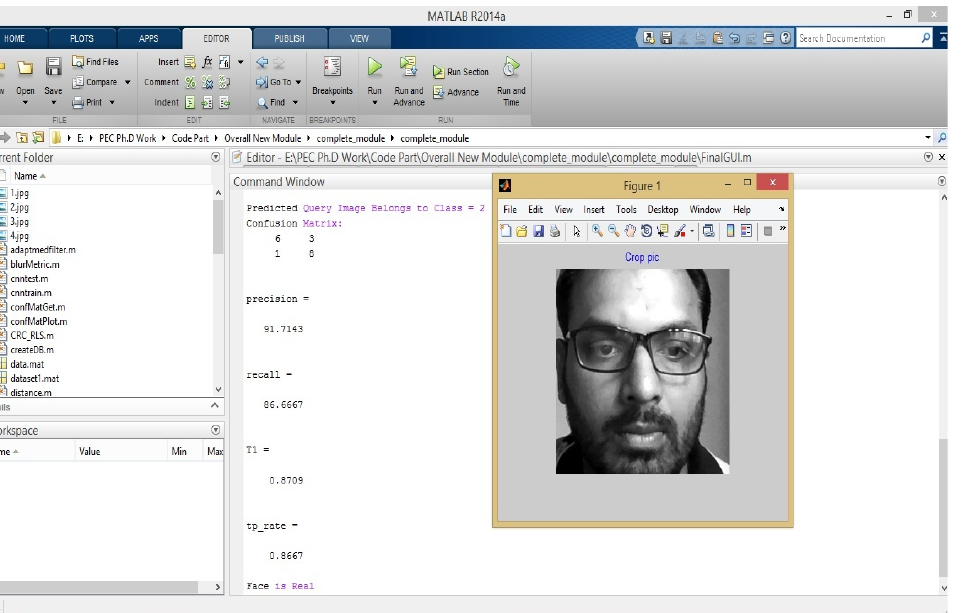
Figure 8. Feature Extraction from cropped Image.